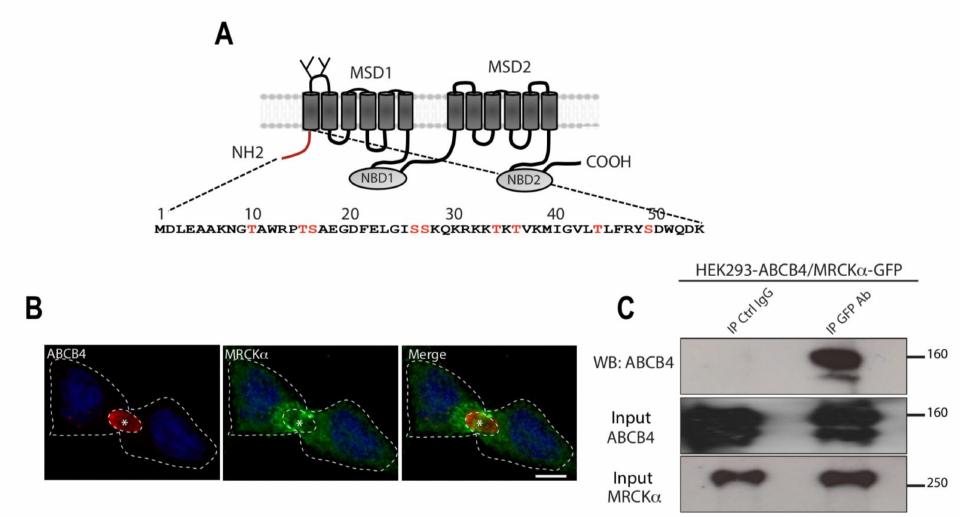
Figure 1. Colocalization and coimmunoprecipitation of ABCB4 with the serine/threonine kinase MRCK α . ( A ) Schematic representation of ABCB4. ABCB4 is composed of two membrane-spanning domains (MSD1 and MSD2) and two nucleotide-binding domains (NBD1 and NBD2). The two glycosylation sites in the first extracellular loop are indicated. The amino acid sequence of the intracytoplasmic N-terminal domain of human ABCB4 isoform A (NP_000434.1) is shown. The serine and threonine residues present in the N-terminal domain of ABCB4 and are indicated in red. ( B ) HepG2 cells transiently expressing ABCB4 were grown on coverslips, fixed, permeabilized, and stained with anti-ABCB4 antibody followed by anti-MRCK α antibody, and then incubated with Alexa-Fluor-594- and 488-conjugated secondary antibodies and visualized by confocal microscopy. Nuclei were stained with DRAQ 5 (Blue). Asterisks indicate bile canaliculi. Bars: 10 mm. ( C ) HEK- 293 cells were co-transfected with plasmids expressing ABCB4 and GFP-tagged MRCK α , and cell lysates were incubated with anti-GFP antibody or mouse immunoglobulin G (IgG) covalently linked to agarose beads. The immunoprecipitated complex was immunoblotted with anti-ABCB4. The presence of MRCK α and ABCB4 in the cell lysate (Input) was detected by immunoblot with anti- MRCK α and anti-ABCB4 antibodies. Presented data were cropped from the full immunoblots shown in Supplementary Figure